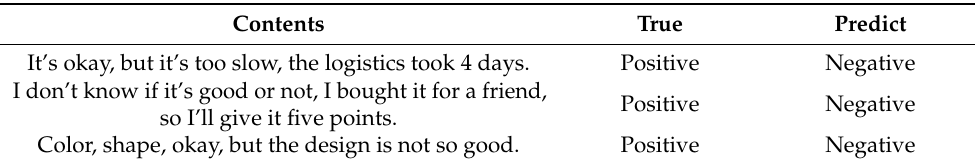
Table 9. Examples of mispredictions.